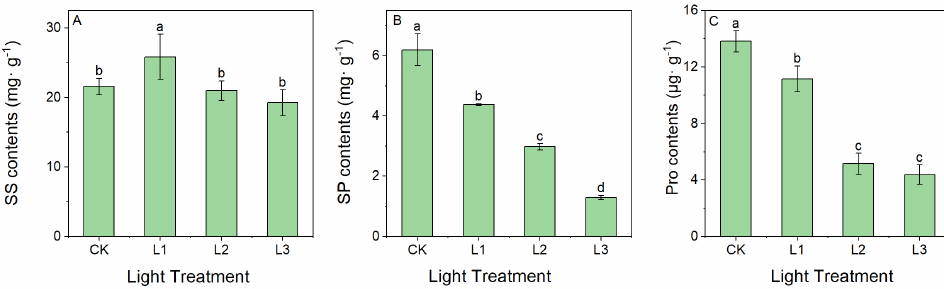
Figure 3. SS contents ( A ), SP contents ( B ), and Pro contents ( C ) in leaves grown under different light intensities. Lowercase letters indicate significant differences under different light intensities ( p < 0.05).